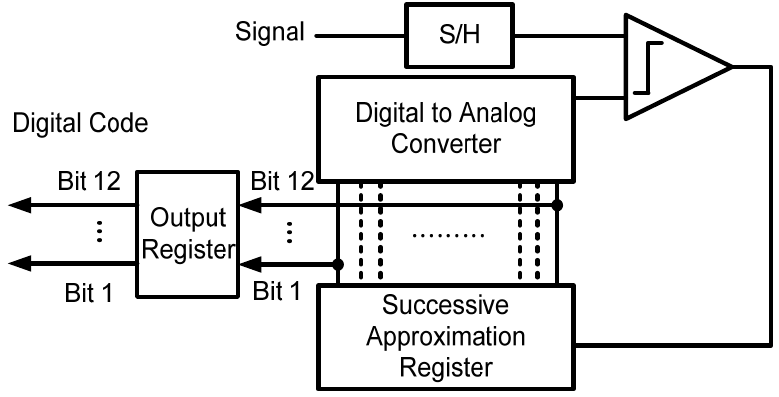
Figure 8. Successive approximation converter